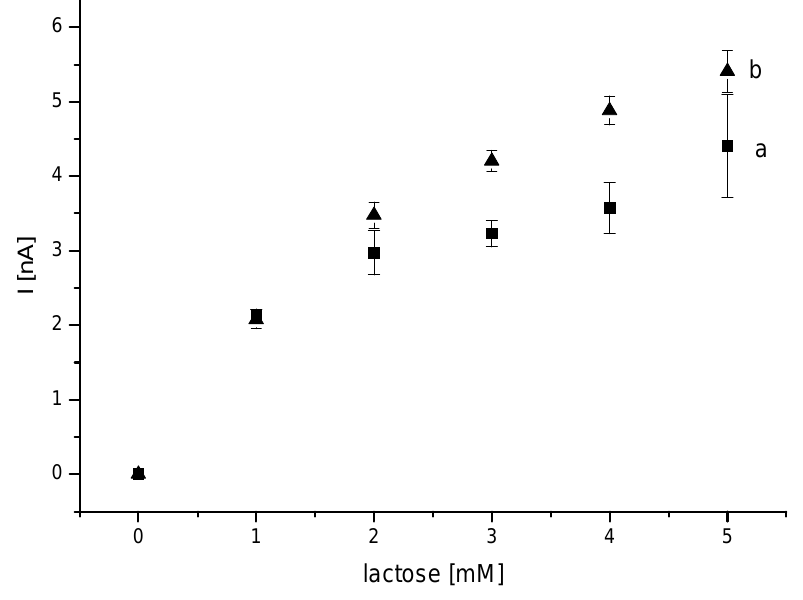
Figure 6. Amperometric current response of Au-MPA-[MWCNT-P(AMB-A)-PDA]/CDH electrode in dependence of the lactose concentration measured at two different pH